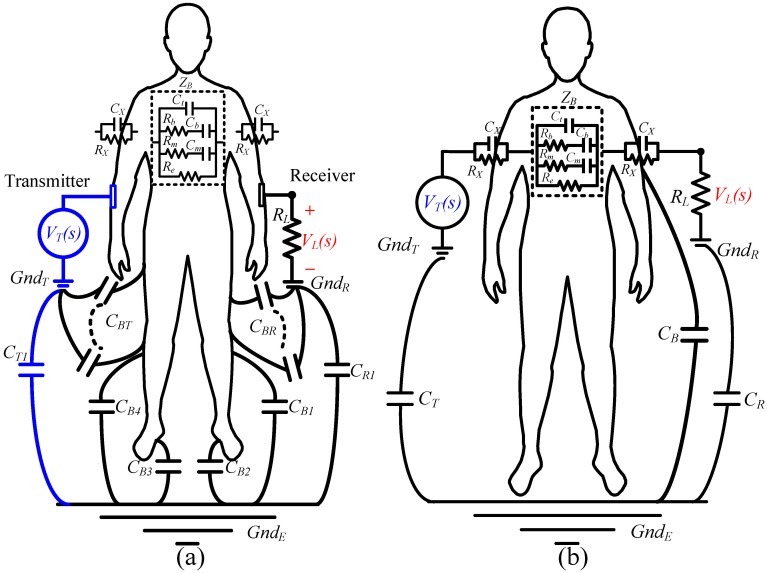
The model of an ESC IBC syatem, (a) the RC circuit model, (b) the simplified circuit model.